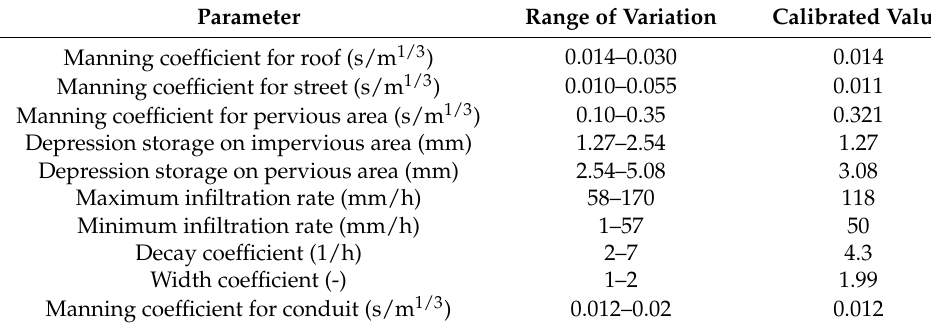
Table 3. The calibrated parameters of the N-LR